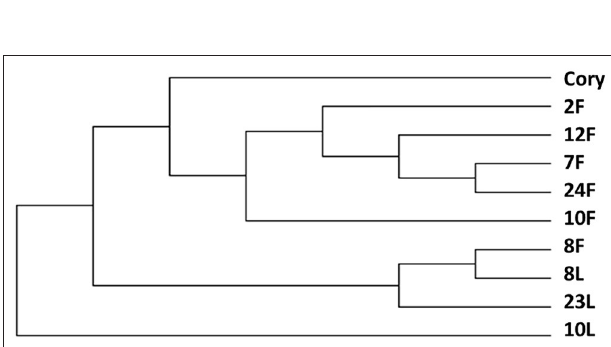
FIGURE 4 | Strain level analysis of Corynebacterium striatum. The C. striatum strain of samples of the 8# patient was similar. F, feces; L,